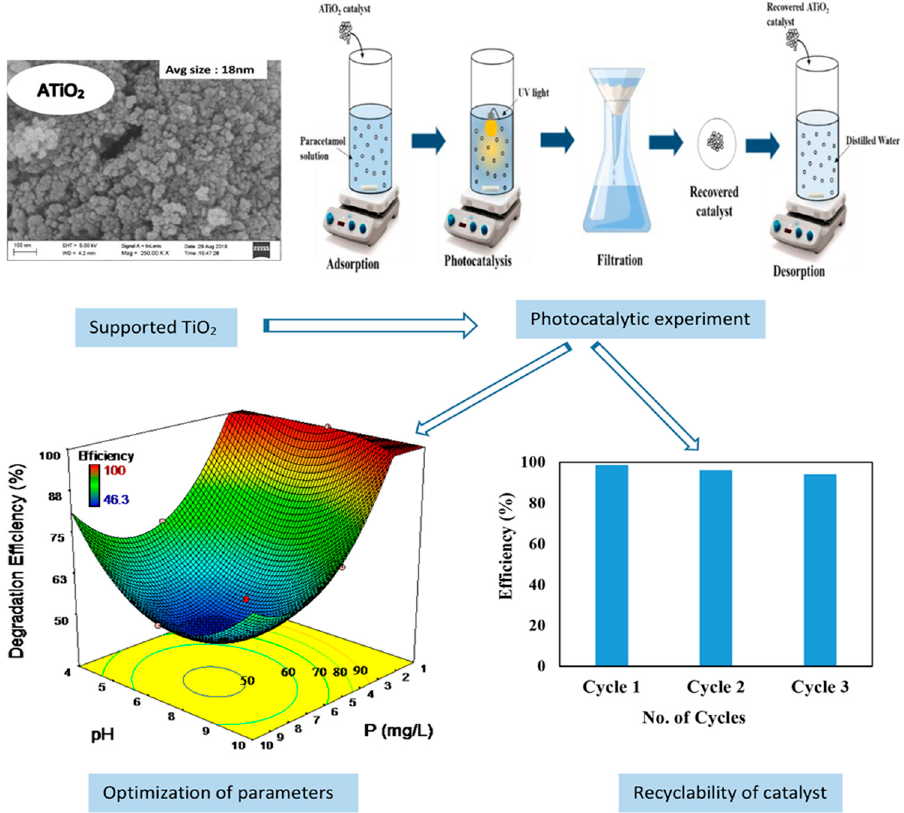
Figure 1. Photocatalytic degradation of ACT: TiO 2 is supported on aluminosilicate salvaged from discarded LED (ATiO 2 ) panels to examine ACT degradation in a batch method. ATiO 2 could be reused up to three times with just a 5% reduction in degrading efficiency. Reprinted/adapted with permission from Ref. [58]. Copyright 2020 IWA (Open Access).